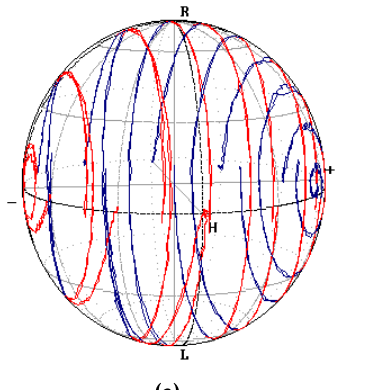
Figure 21. Comparison between experimental data points as read on the polarimeter (blue squares) and as deduced from the dissipated power on each heater (red), measured by the sourcemeter and correcting the effect of the parasitic common ground electrode resistance. The start point for P 1 and P 2 = 0 is that with s 1 = 1. Increasing P 1 produces a counter clockwise rotation around the s 2 axis, − P 2 on the s 3 axis, when P 1 = 0.